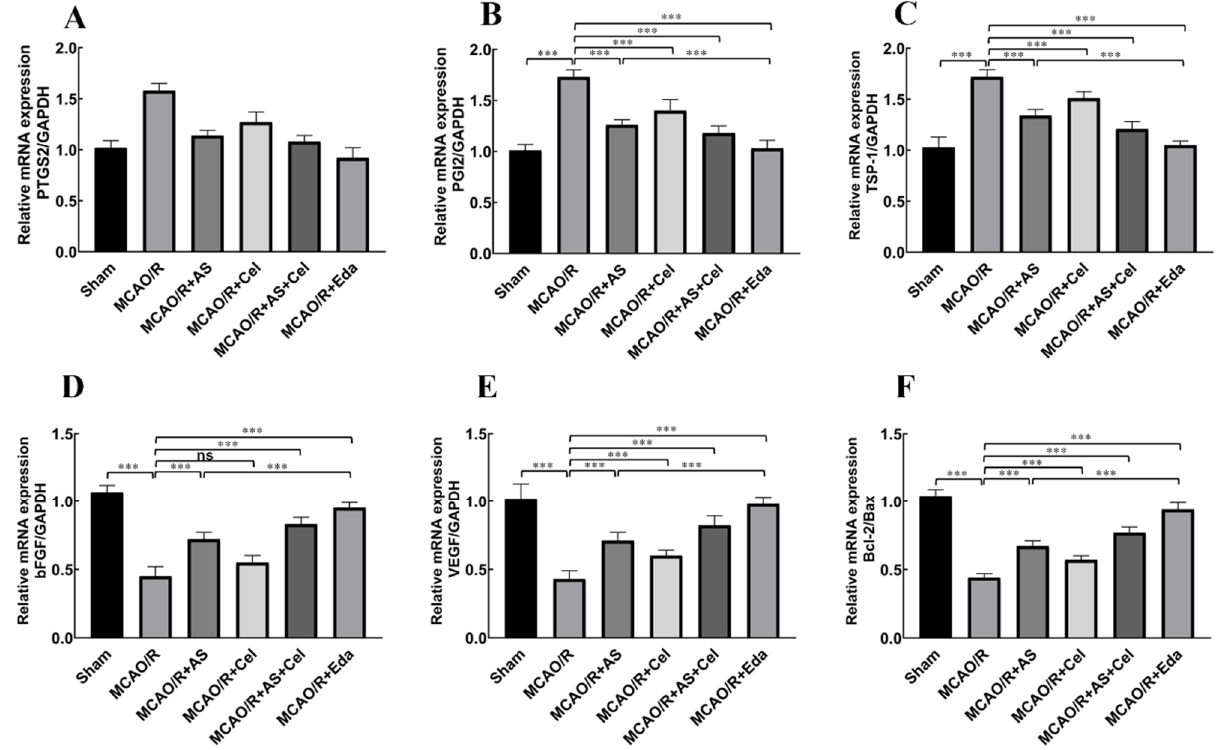
Figure 8. AS treatment promoted angiogenesis by inhibiting PTGS2. The mRNA expression of PTGS2 ( A ), PGI2 ( B ), TSP ‐ 1 ( C ), Bax ( D ), Bcl ‐ 2 ( E ), VEGF ( F ), and bFGF ( G ) was detected by PCR. (n = 3 rats for each group). Data are expressed as the mean ± SD, *** p < 0.001; ns stands for no statistical significance.